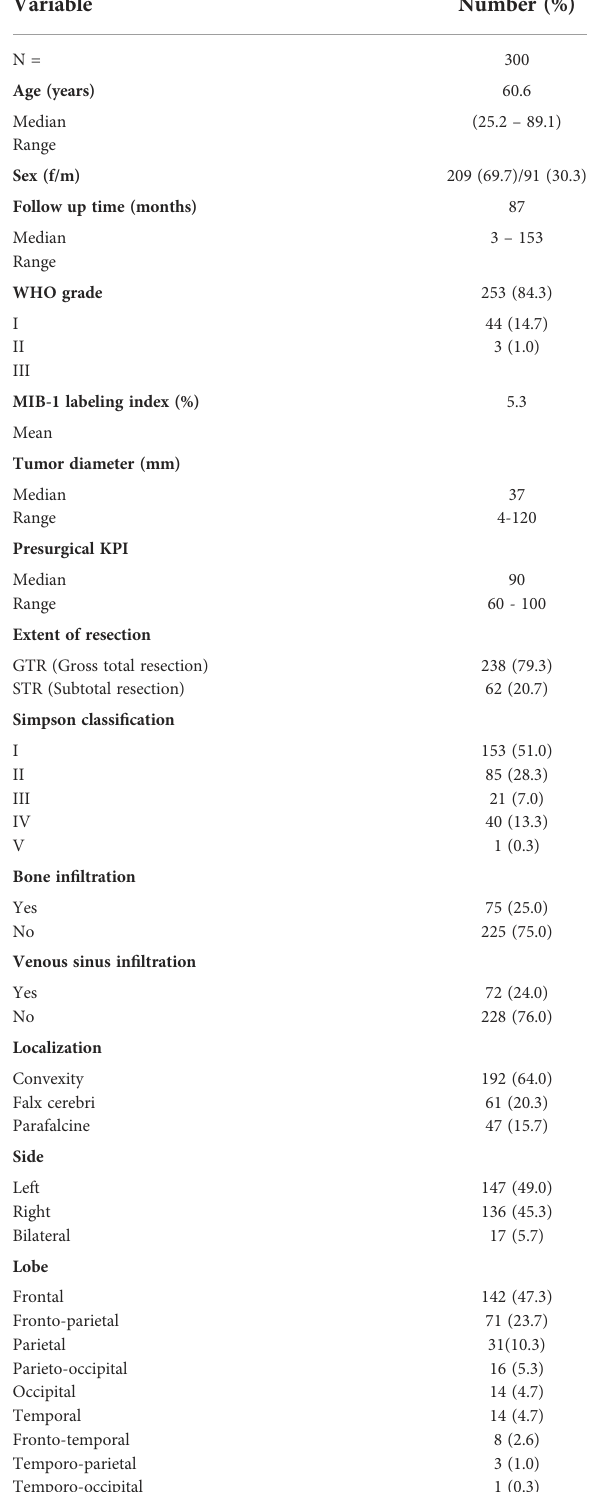
TABLE 1 Clinical characteristics of the entire patient